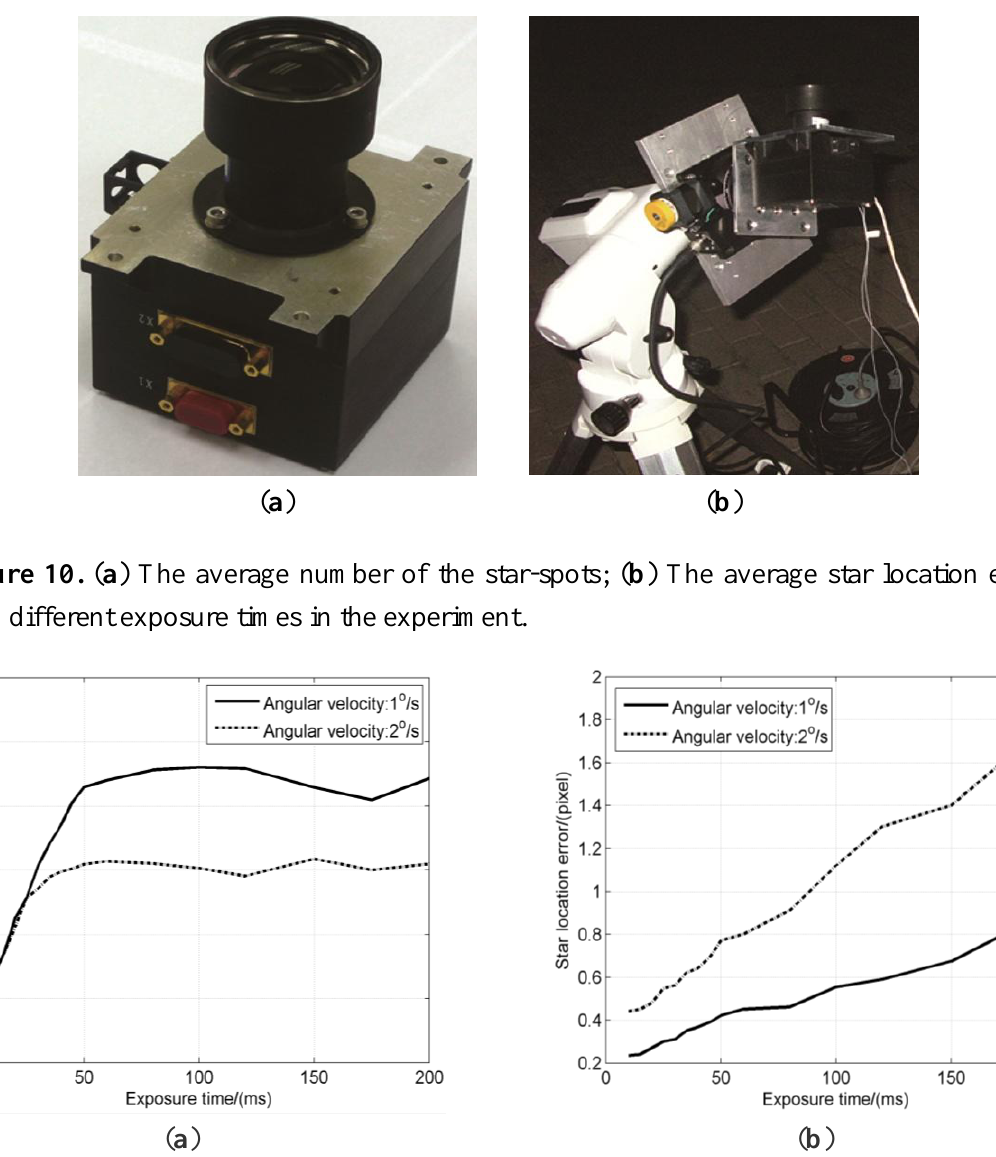
Figure 9. ( a ) The star tracker used in the experiment; ( b ) Night sky experiment setup.